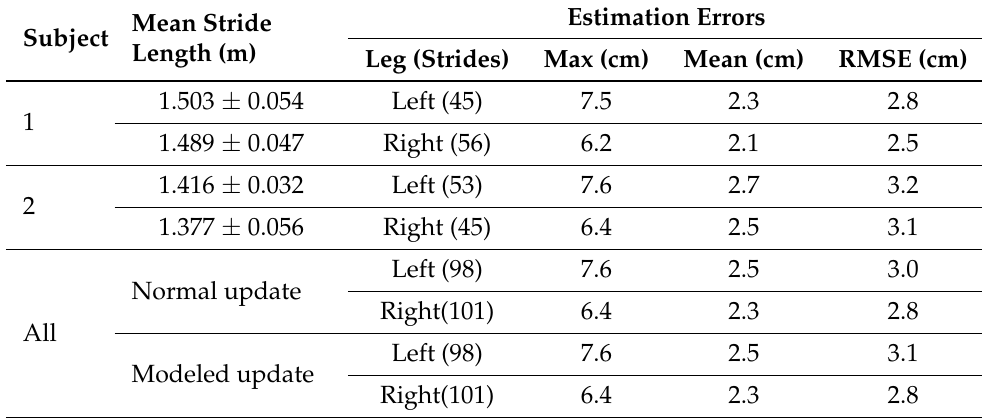
Figure 13. The histogram of all walking stride length estimation errors of the proposed method. Table 4. The stride length estimation results compared with the optical OptiTrack system.